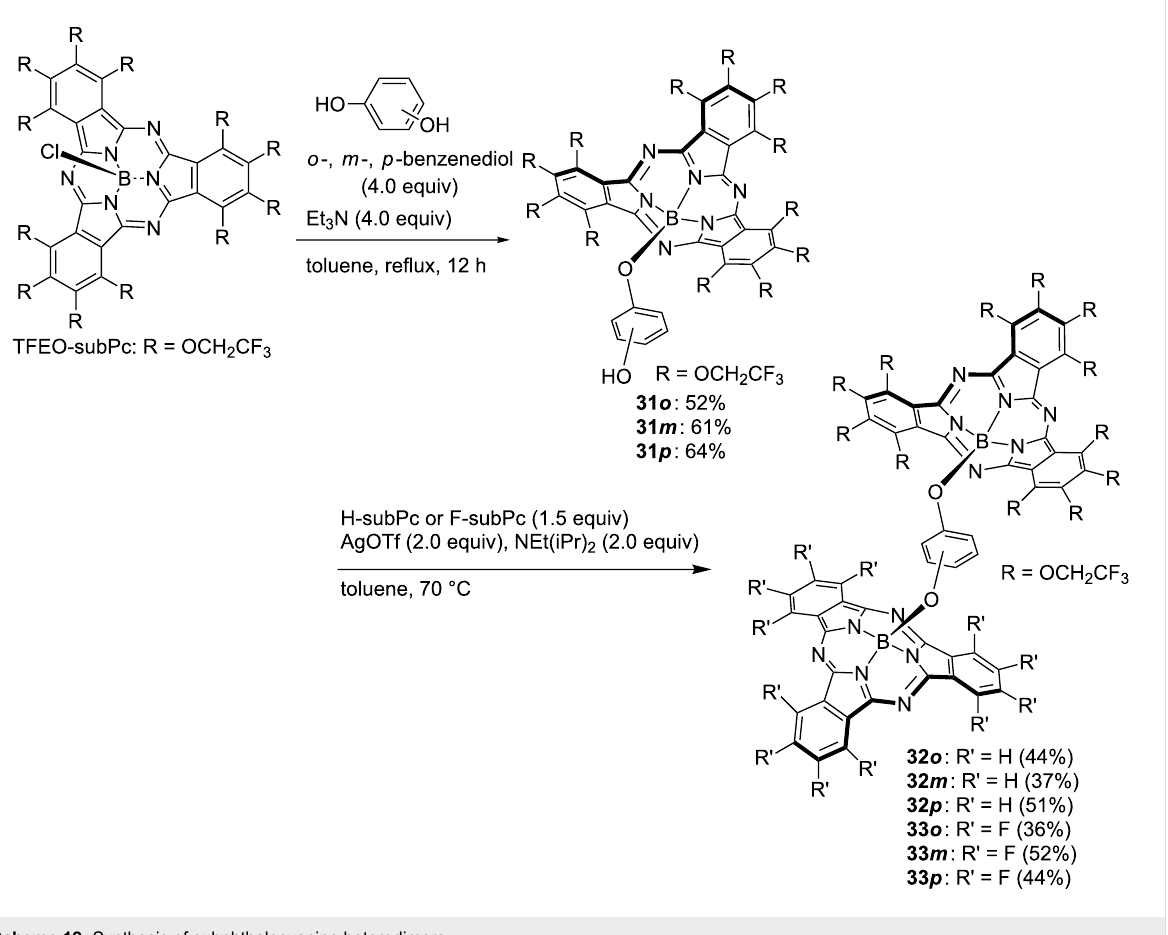
Scheme 12: Synthesis of subphthalocyanine